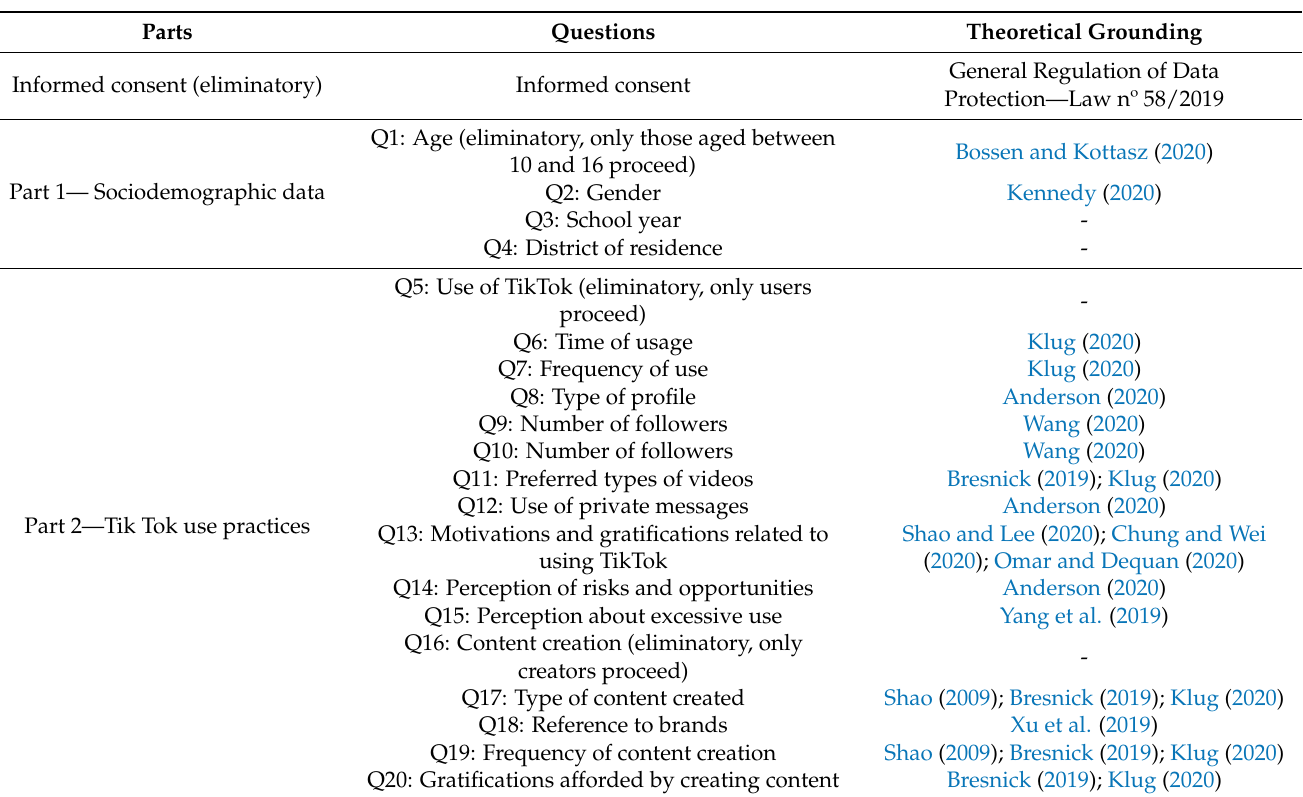
Table 1. Structure of the